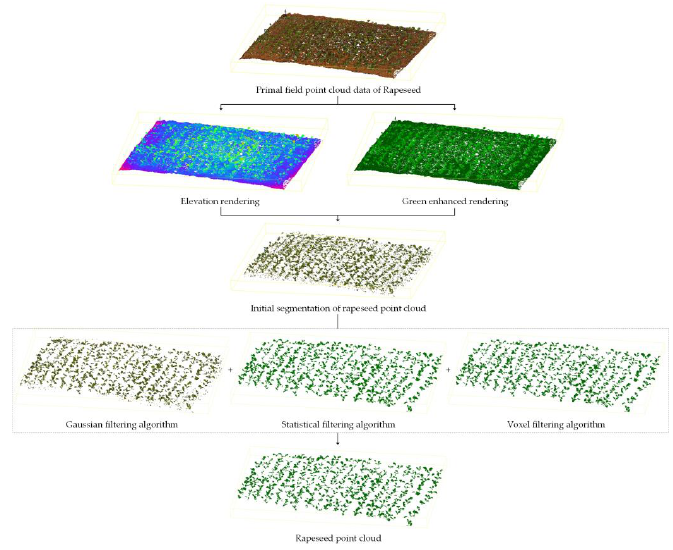
Figure 3. Hybrid filter for Rapeseed point cloud extraction.